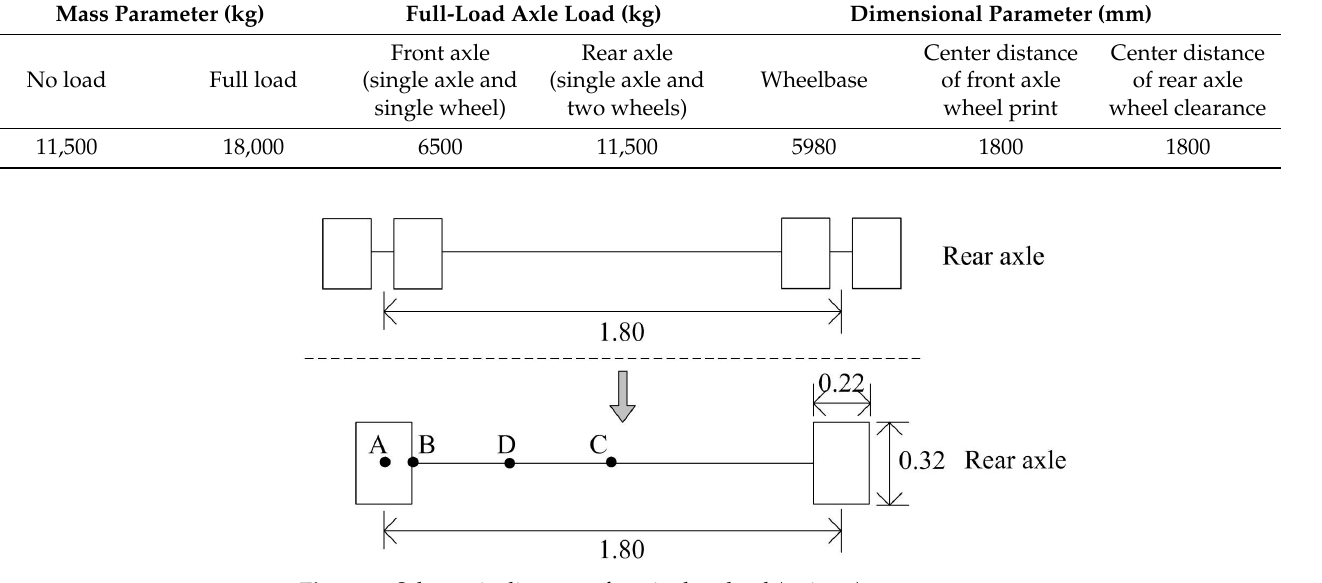
Figure 2. Schematic diagram of equivalent load (unit: m).